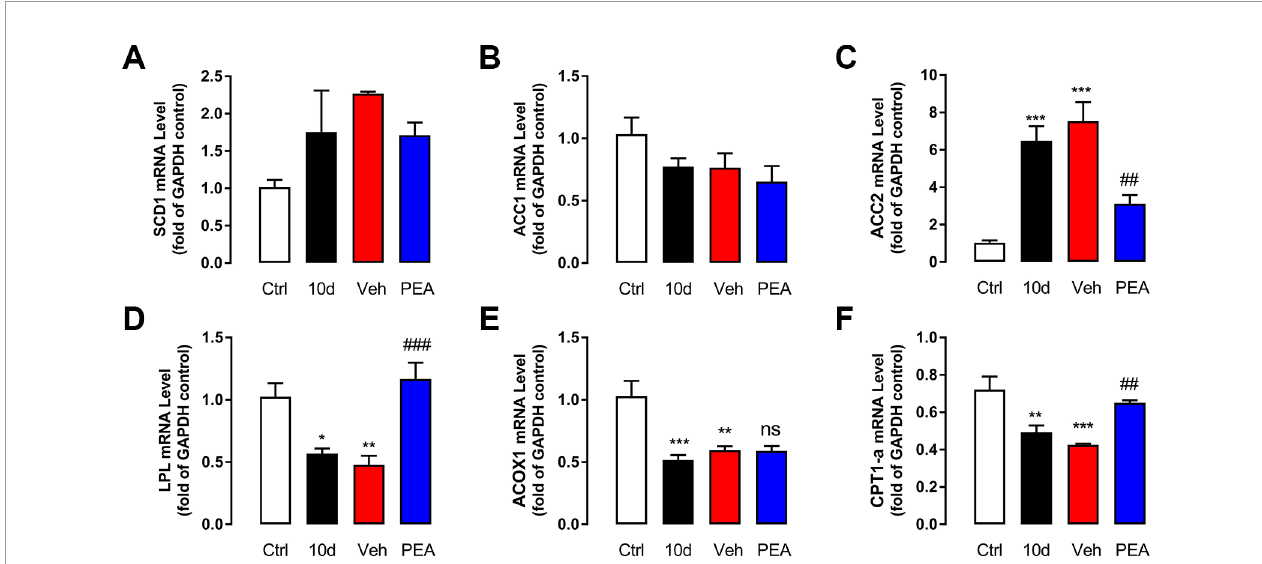
FIGURE 4 | PEA administration normalized the mRNA levels related with lipid metabolism. The effects of control (blank), SD (model), vehicle (solvent), and PEA (30 mg/kg) on mRNA expression levels of SCD1 (A) , ACC1 (B) , ACC2 (C) , LPL (D) , ACOX1 (E) , CPT1- a (F) in mouse LG. ns, not signi fi cant; *, P < 0.05, **, P < 0.01,